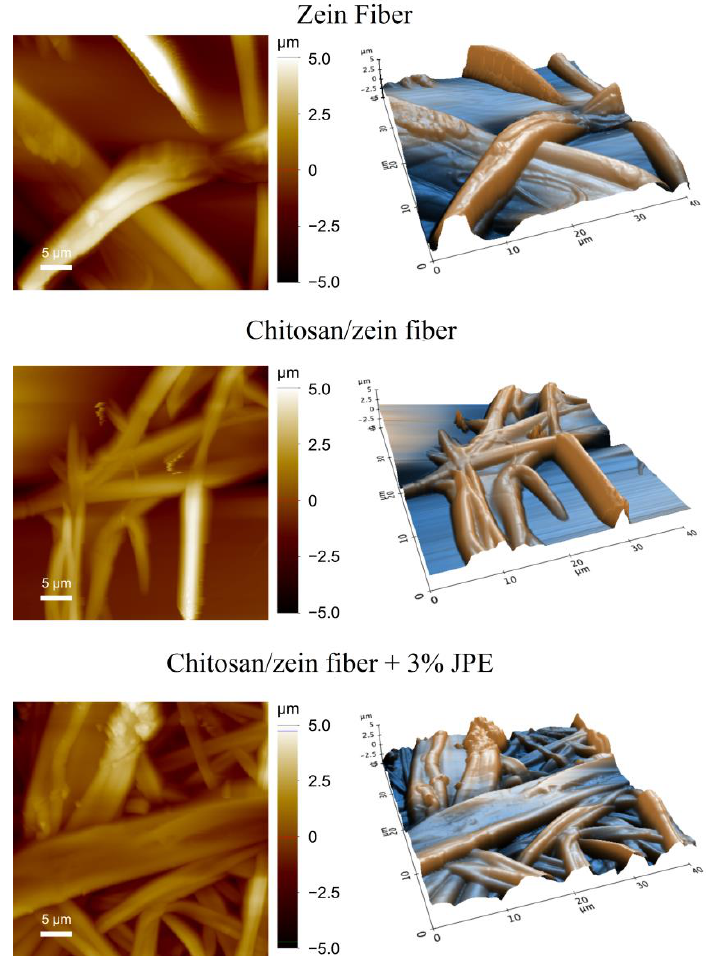
Figure 4. AFM images of zein fiber, chitosan/zein fiber, and chitosan/zein fiber + 3% of JPE. Table 4. Roughness and mean diameter of zein fiber, chitosan/zein fiber, and chitosan/zein fiber + 3% of JPE.